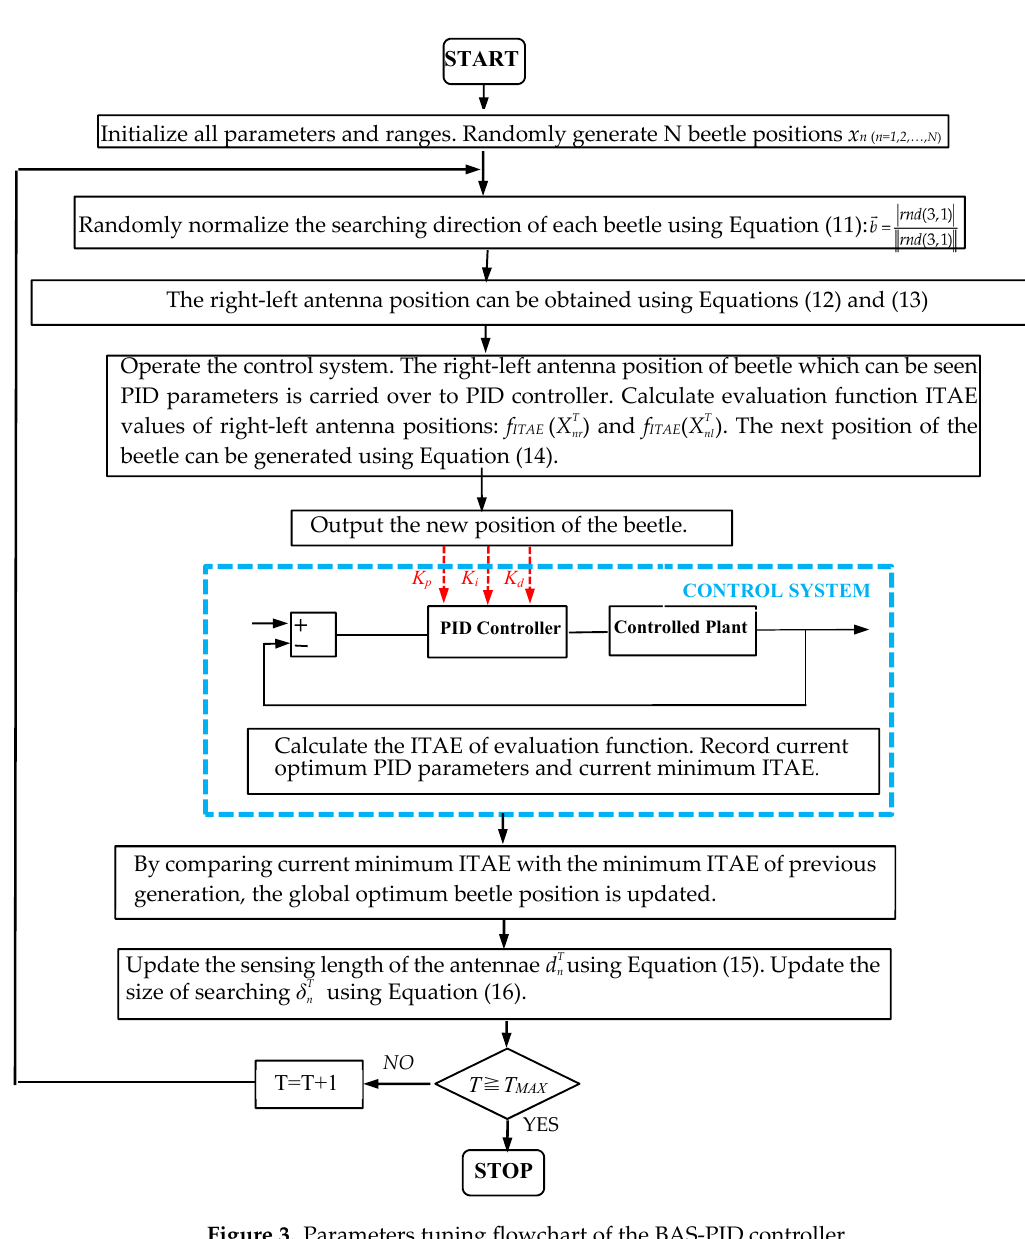
Figure 3. Parameters tuning flowchart of the BAS-PID controller.